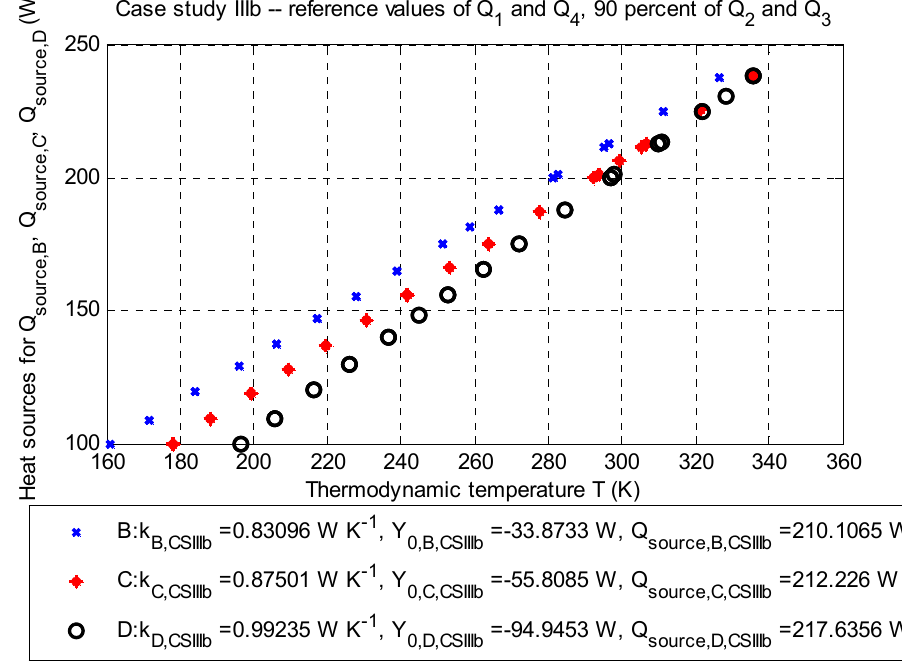
The number of samples: N = 684 . Vector of constrained limits: L = (cid:3419)x (cid:2868) , x (cid:2922)(cid:2925)(cid:2933)(cid:2915)(cid:2928) ,x (cid:2931)(cid:2926)(cid:2926)(cid:2915)(cid:2928) (cid:3423) = (cid:4668)200, 100, 250(cid:4669) W .